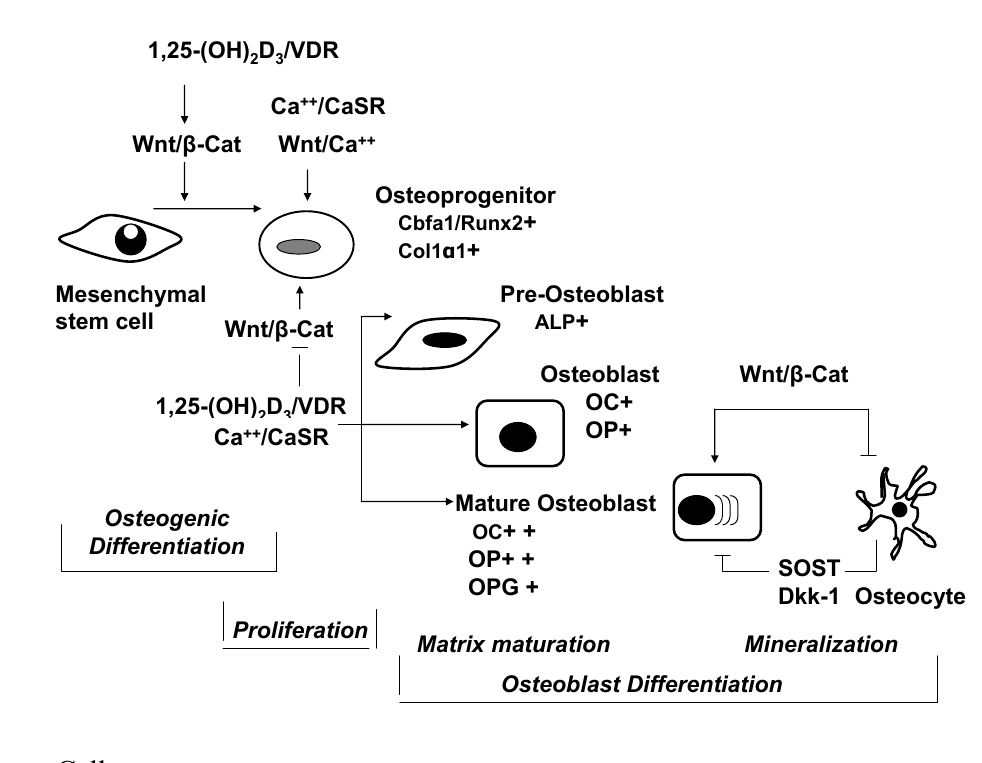
Figure 2. Cooperative signaling from Ca 2+ /CaSR and 1,25-(OH) pathways and formation of mineralized